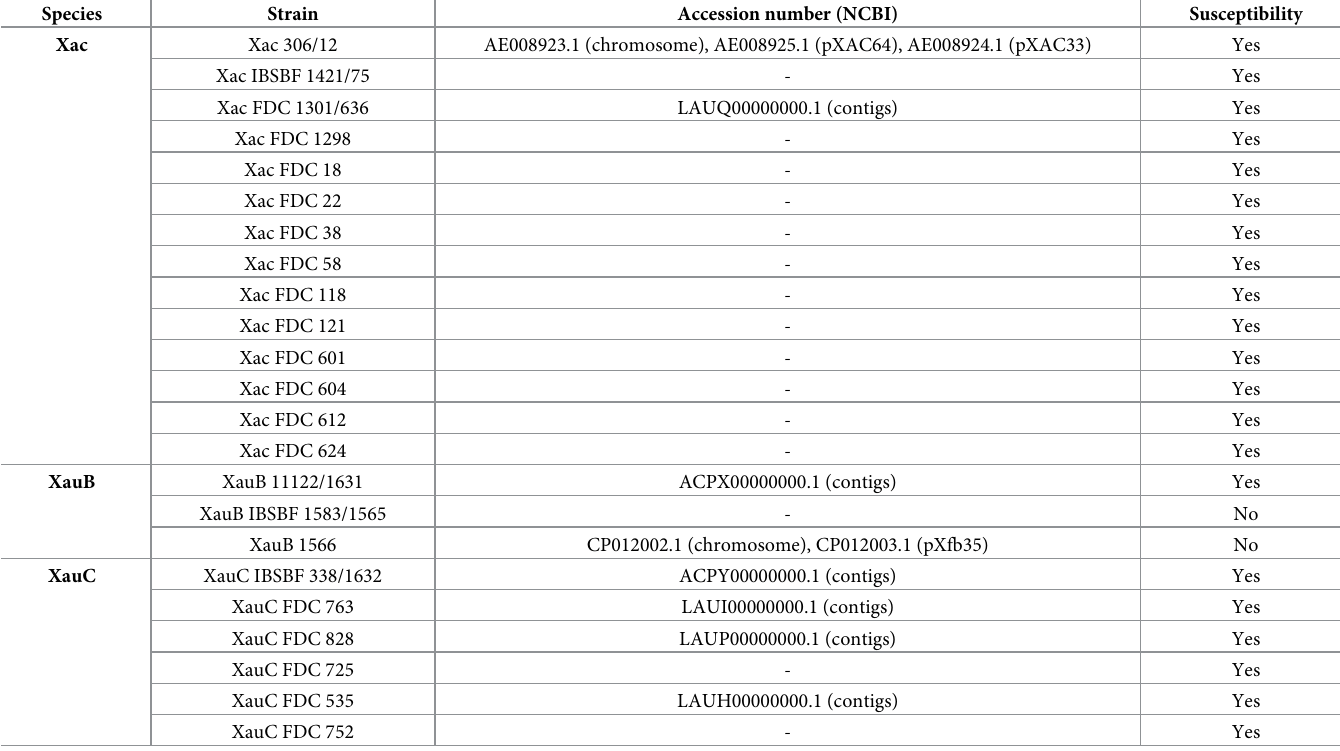
Table 1. Susceptibility of X . citri and X . fuscans strains to vB_XciM_LucasX. Species Strain Accession number (NCBI)